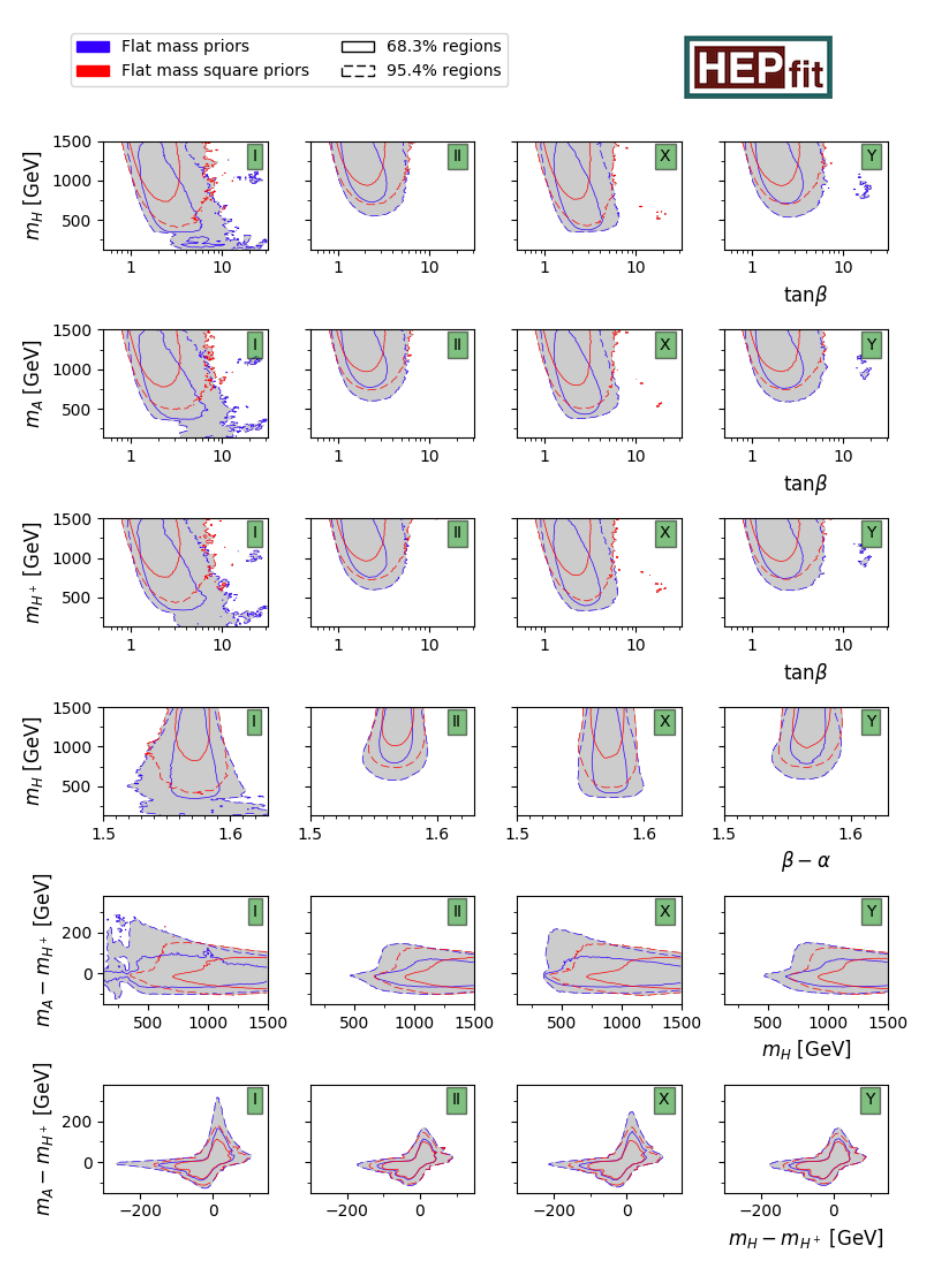
Figure 13 . The mass prior dependence of the (cid:12)t with all constraints is shown in the m vs. tan (cid:12) planes, in the m H vs. (cid:12) (cid:0) (cid:11) planes (corresponding to (cid:12)gure 4) and in the m A (cid:0) m vs. m H and m A (cid:0) m vs. m H (cid:0) m planes (corresponding to (cid:12)gure 5), from top to bottom. H + H +